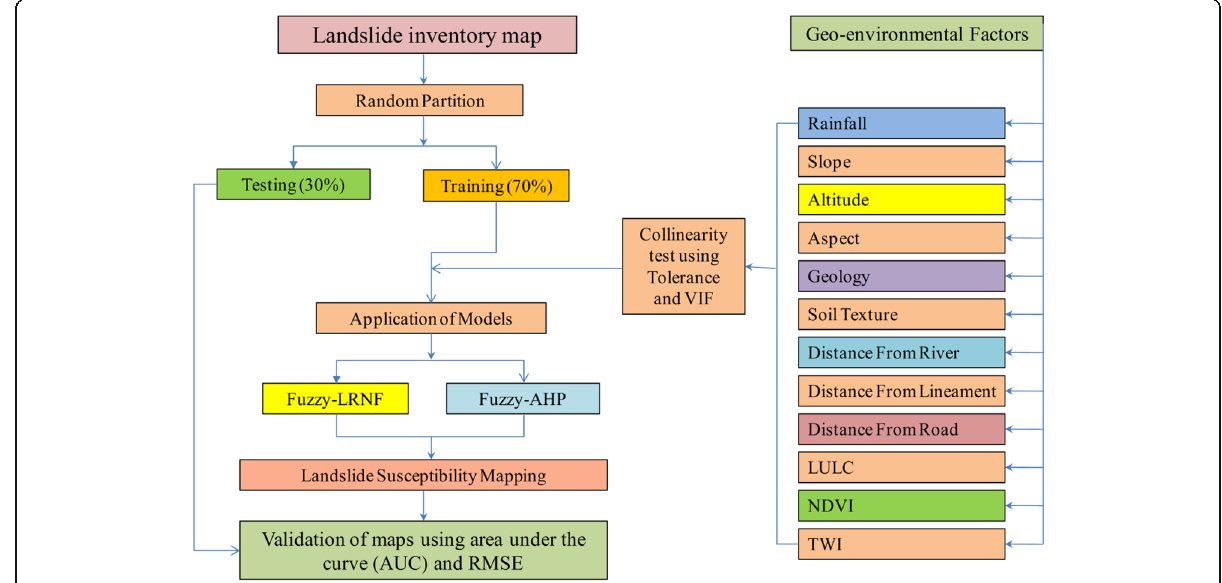
Fig. 2 Flowchart of methodology used in this